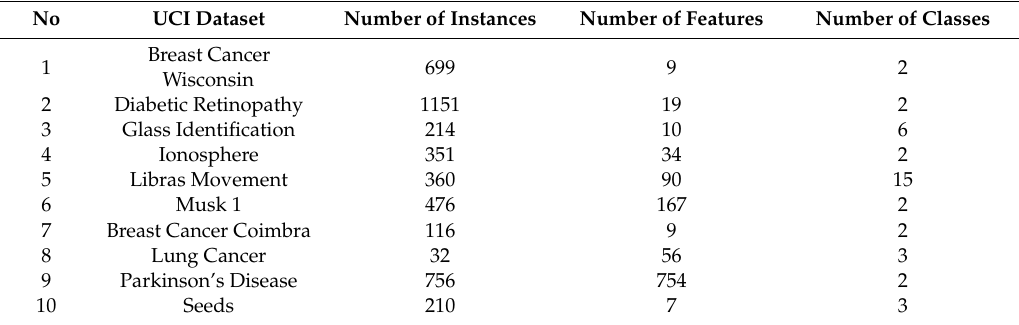
Table 1. The ten utilized benchmark datasets.